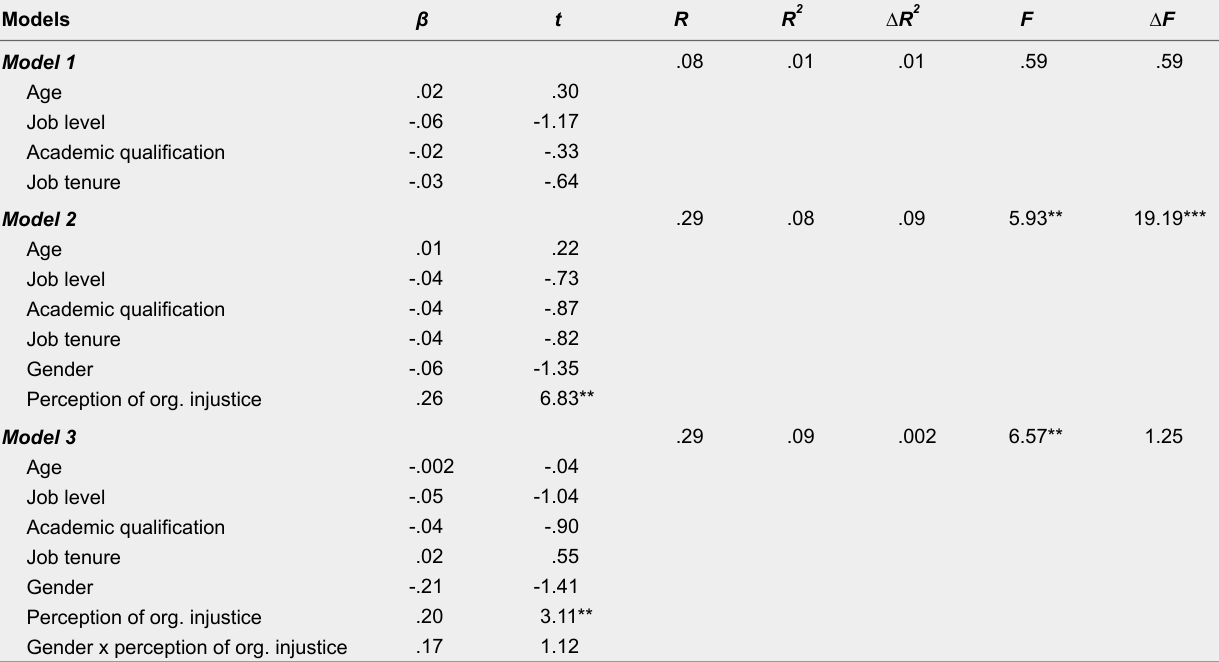
Hierarchical Multiple Regression on Corrupt